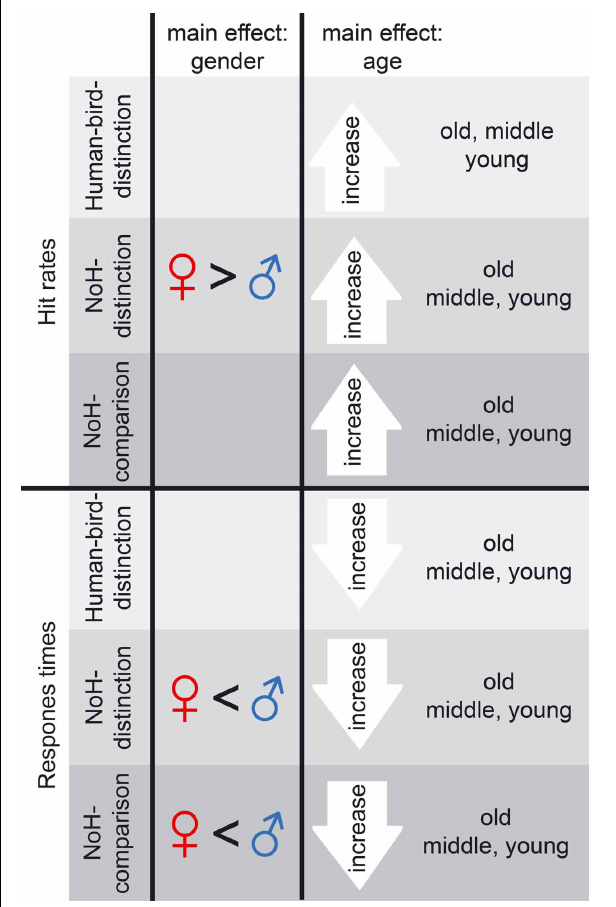
FIGURE 3 | Summary of age and gender main effects. Main effects on hit rates (top) as well as on RTs (bottom) are shown for gender (left) and age (right). Main effects are shown for Human-bird-distinction (light gray), NoH-distinction (medium gray) and NoH-comparison (dark gray). Note that main effects of gender were present in help-related paradigms